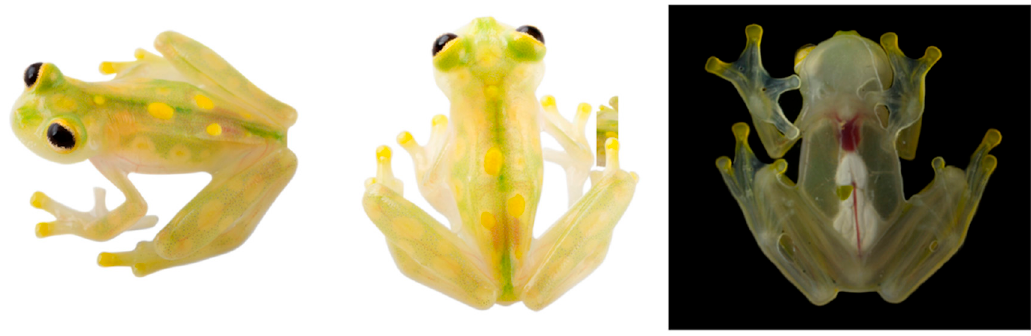
Figure 102. Hyalinobatrachium aureoguttatum in life. ( Left and center ) Adult male, QCAZ 45365; photos by L. A. Coloma. ( Right ) Adult male, QCAZ 32068; photo by Martín Bustamante.